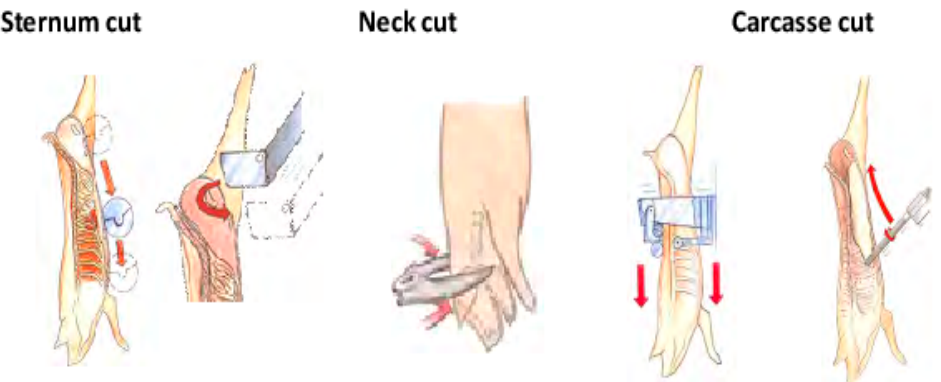
Figure 1. A robotic auto-processing technique for pork carcasses [24] (From Matthieu et al. Robotic solutions for meat cutting and handling. Reprinted with permission of Matthieu et al. Copyright © 2014).